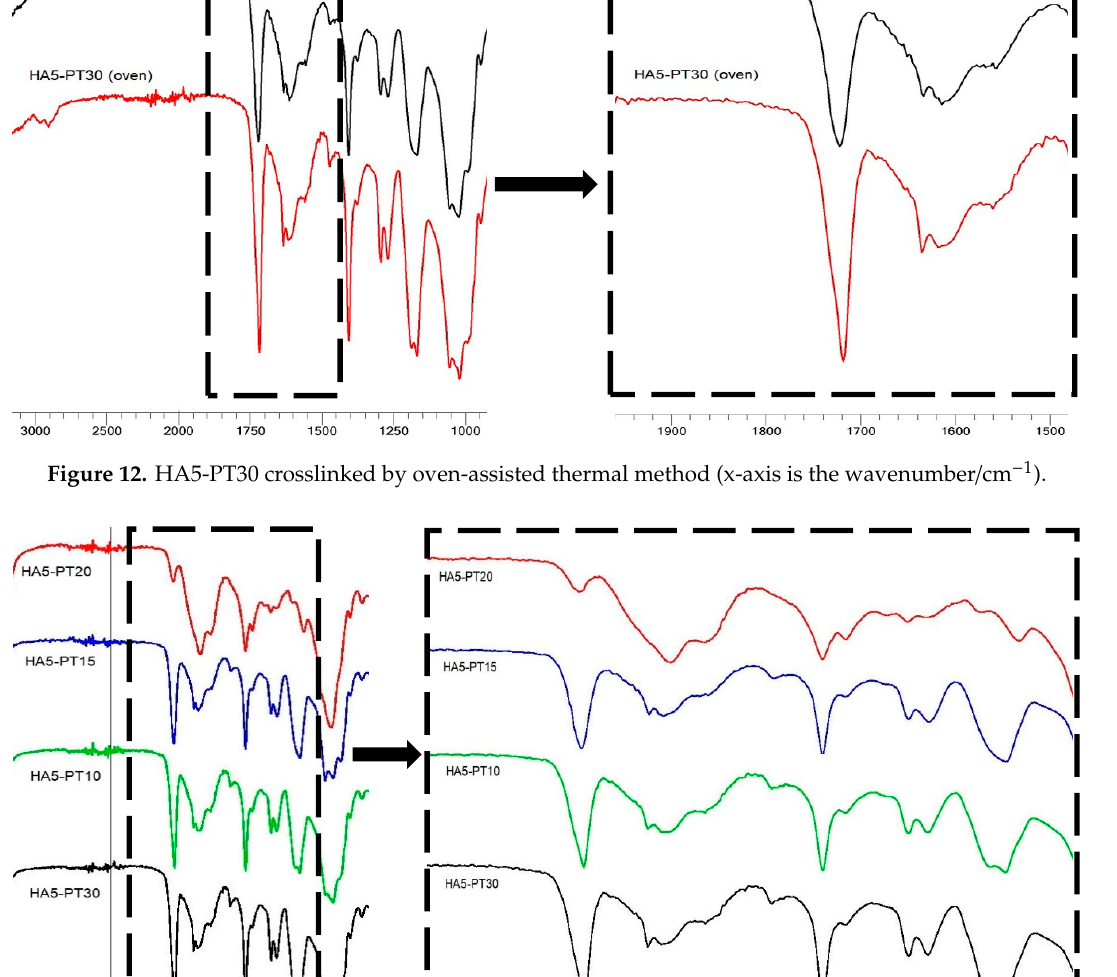
Figure 13. HA5-PT crosslinked by oven-assisted thermal method (x-axis is the wavenumber/cm − 1 ).